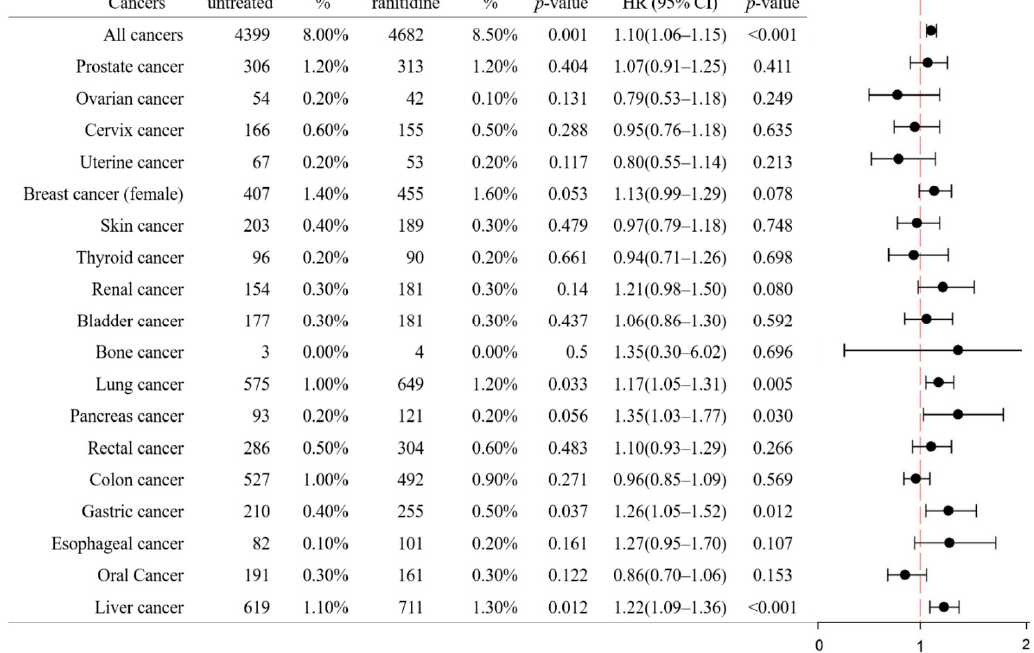
Figure 2. Number and proportion of 18 different cancer reports in the ranitidine and non-ranitidine cohorts and the associated proportional reporting ratios and 95% confidence intervals in multivariate Cox proportional hazards regression adjusted for competing mortality.